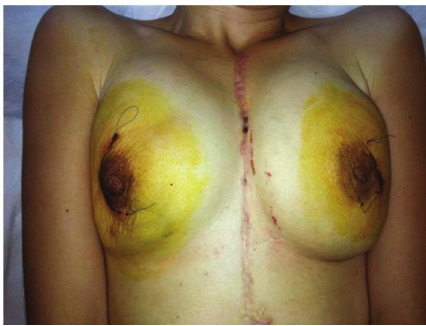
Figure 1: Right subcutaneous mastectomy and left segmental mastectomy were performed to the patient with bilateral recurrent breast abscesses after sternotomy. Photo being taken at postopera- tive 3rd